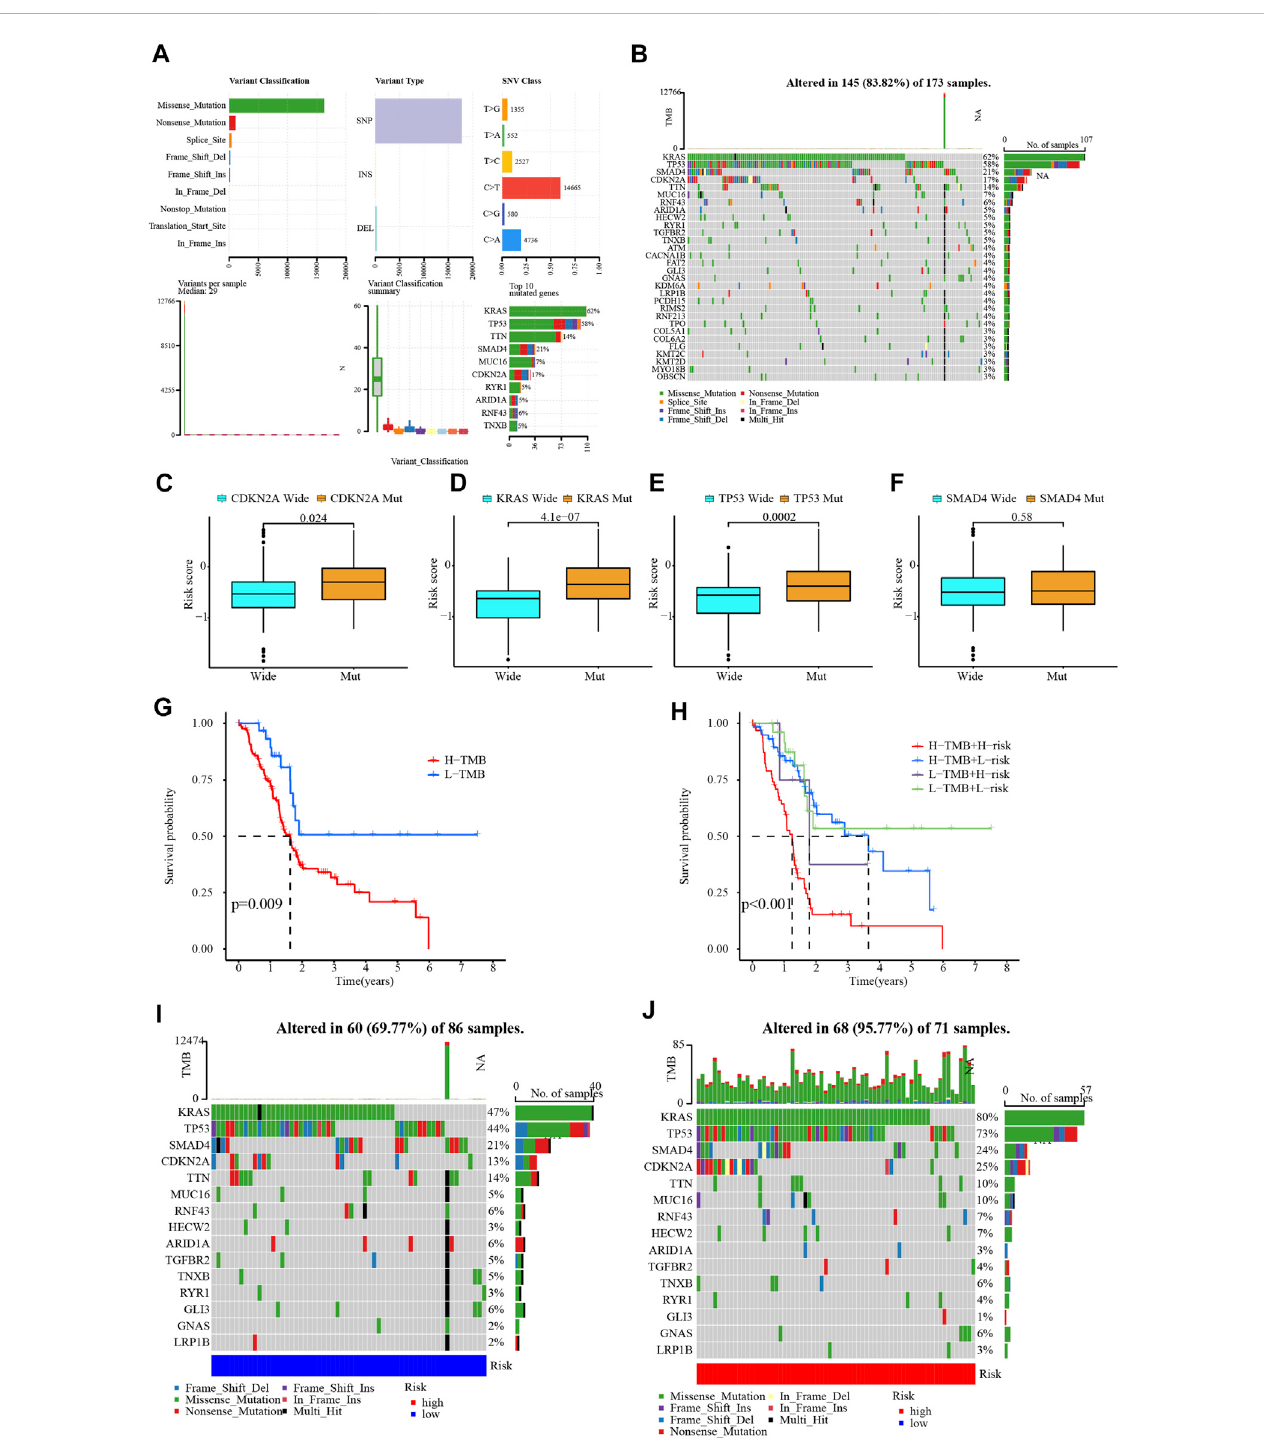
FIGURE 8 Mutation analysis of samples. (A,B) Waterfall plot for the PC patients in TCGA database. (C – F) The relationship between CDKN2A, KRAS, TP53, and SMAD4 gene mutation with risk score. (G,H) The relationship between TMB and PC survival. (I,J) Waterfall plots in different risk